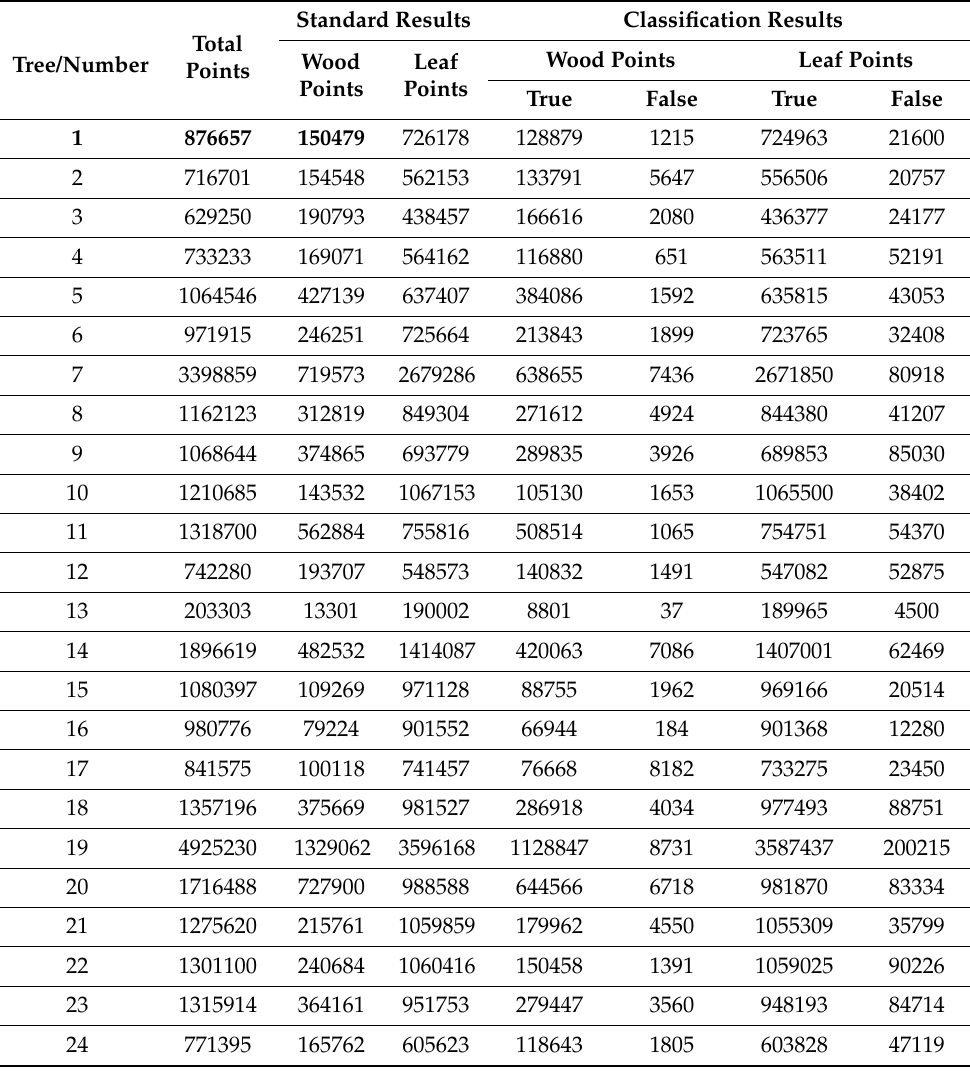
Table 4. The point statistics information of 24 trees classification